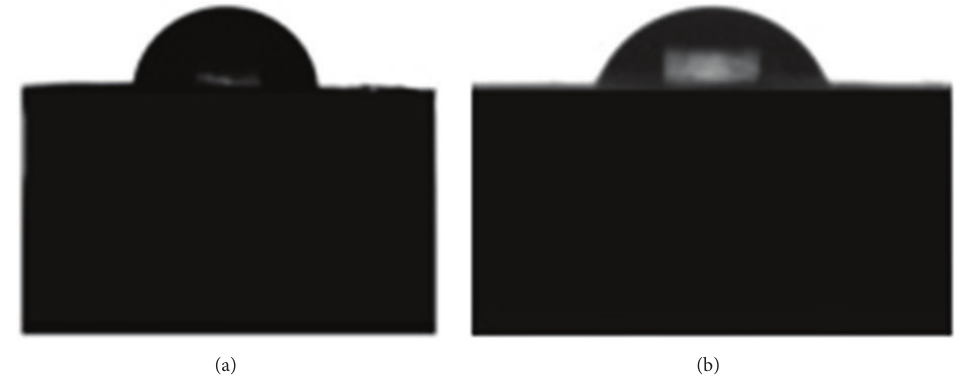
Figure 8: Water contact angle of (a) M-PES and (b)